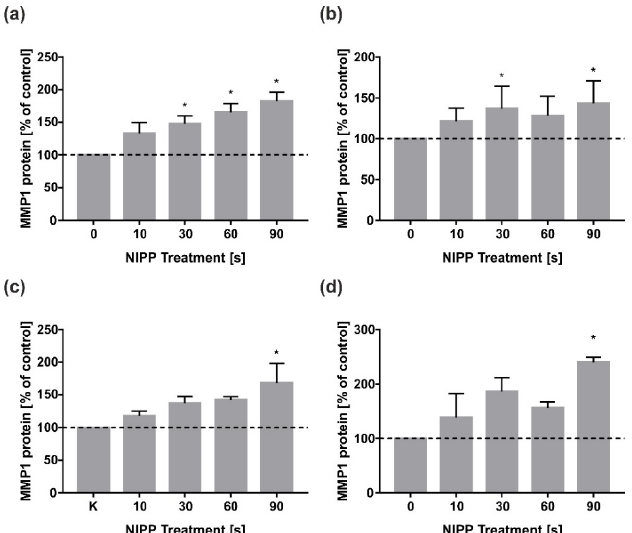
Figure 4. Effects of NIPP on MMP1 protein levels in HGF and HGK at 24 h and 48 h, respectively. Protein levels were related to total protein and normalised to control. Treatment was performed for the indicated times: ( a ) MMP1 concentration in HGF cell culture supernatants at 24 h; ( b ) MMP1 concentration in HGF cell culture supernatants at 48 h; ( c ) MMP1 concentration in HGK cell culture supernatants at 24 h; ( d ) MMP1 concentration in HGK cell culture supernatants at 48 h. n = 6. * statistical significance compared to control (0 s) ( p < 0.05).